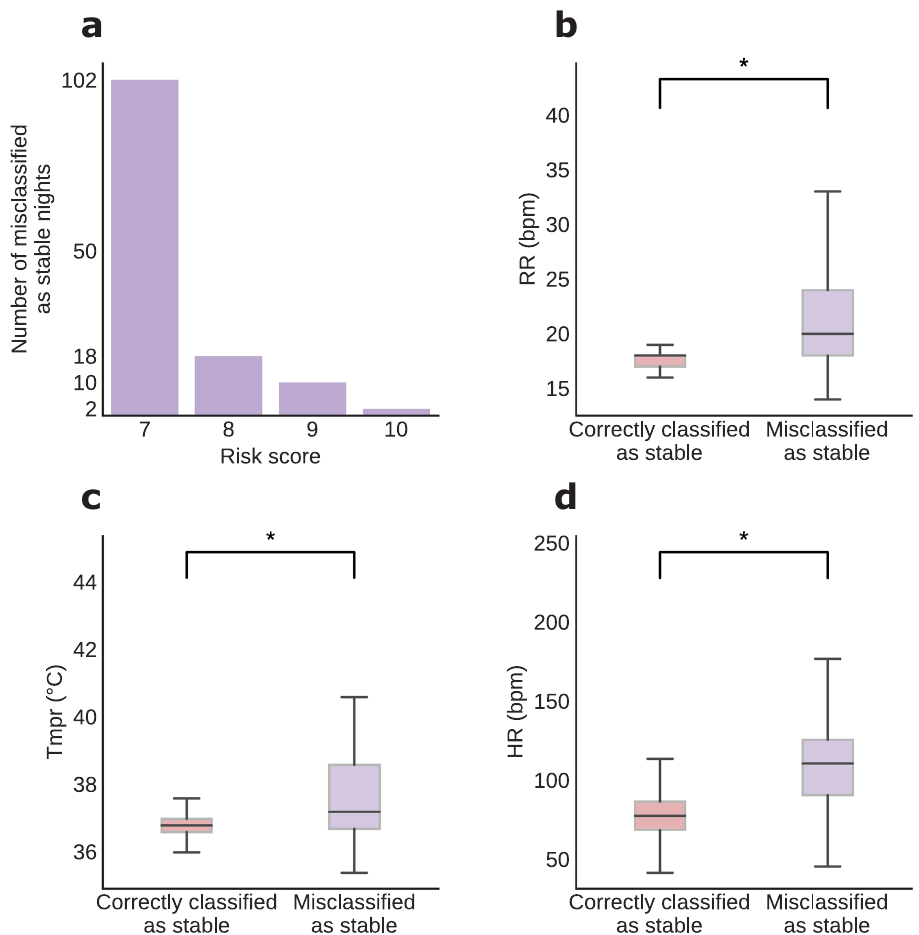
Fig. 5 Differences in nighttime vital sign measurements between patients correctly and erroneously classi fi ed as stable in the retrospective test set. For the 132, erroneously classi fi ed as stable patient, 77% had a risk score of 7, which just met the threshold of potentially unstable, and in only 2 instances did the level reach up to 10 ( a ). Vital signs measured during stable (true positive) and potentially unstable (false positive) were compared, and all were found to be signi fi cantly different between the two groups, with respiratory rate (RR; b ), temperature (Tmpr, c ), and heart rate (HR, d ) all higher in the misclassi fi ed as stable patients ( p < 0.001 for all